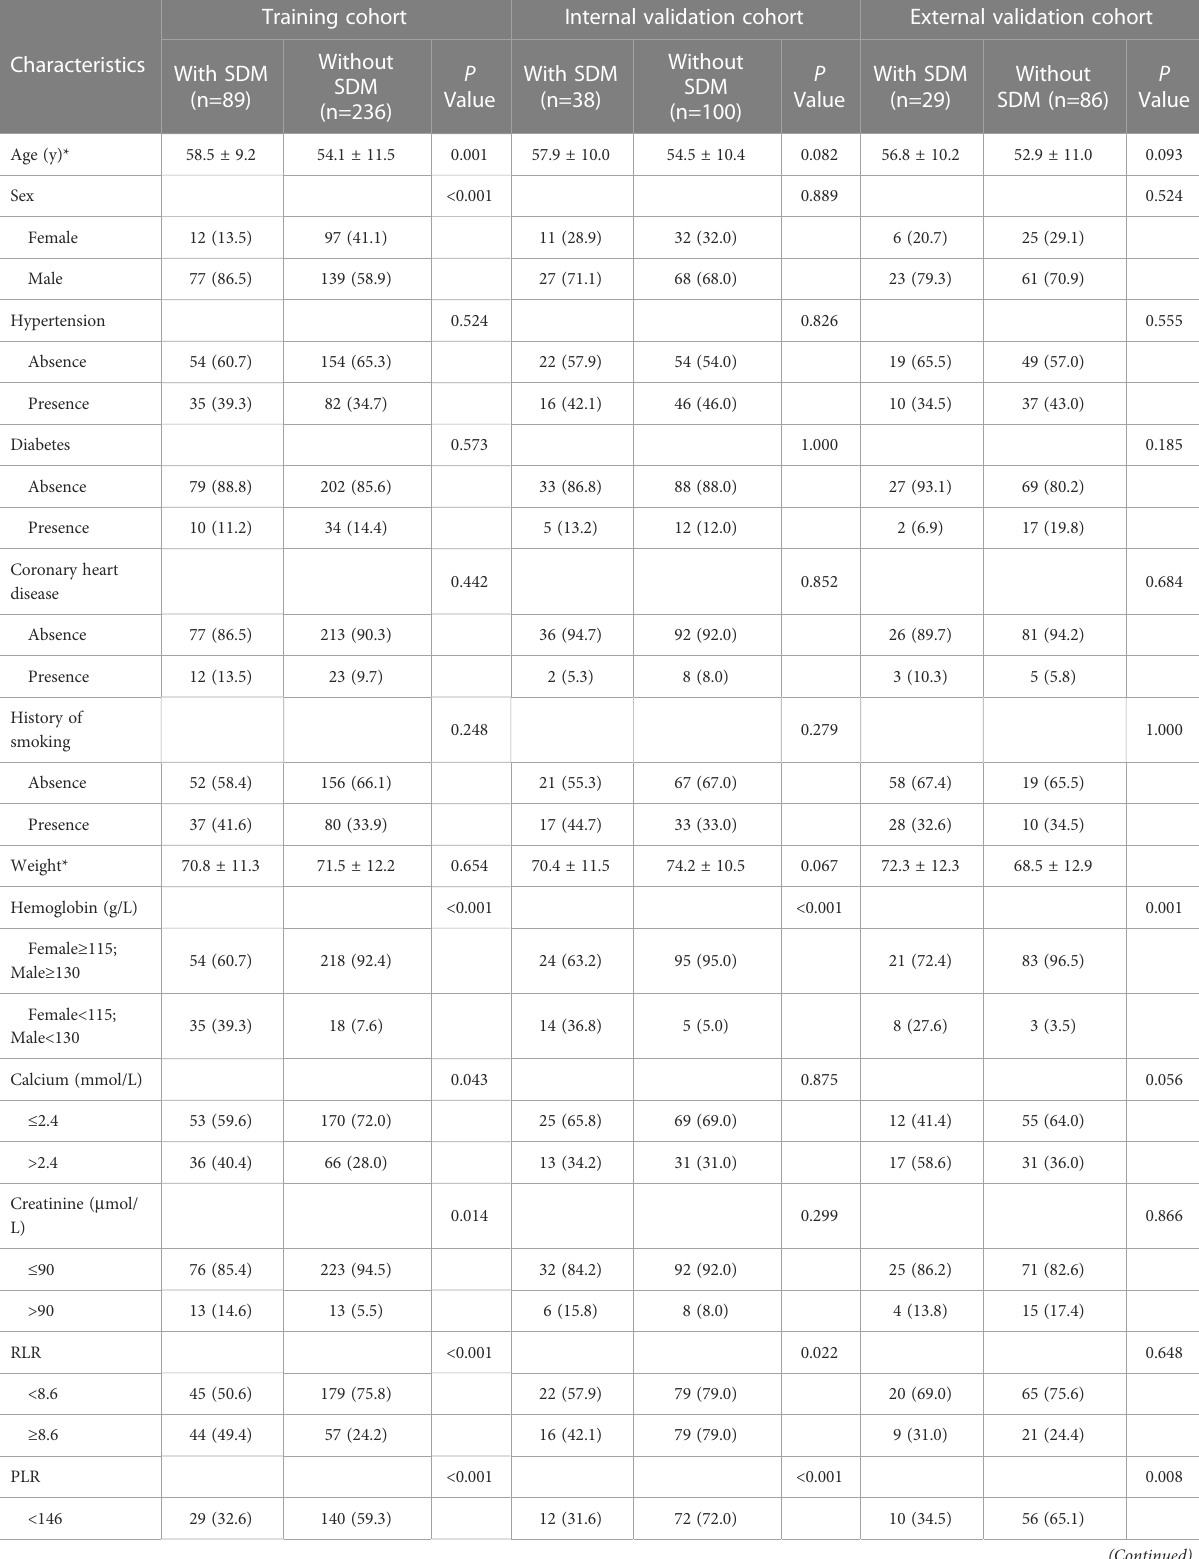
TABLE 1 Comparison of patient clinicoradiological characteristics of with and without SDM ccRCC.